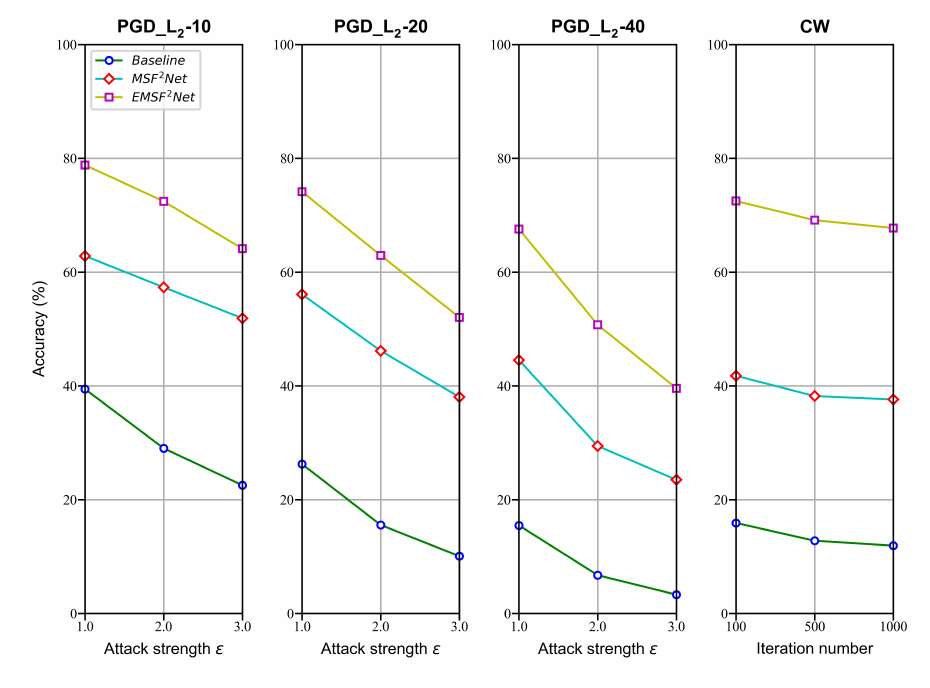
Figure 3. Robust classification accuracy of the baseline, MSF 2 Net, and EMSF 2 Net under adversarial attacks using the L 2 -norm on the CIFAR-10